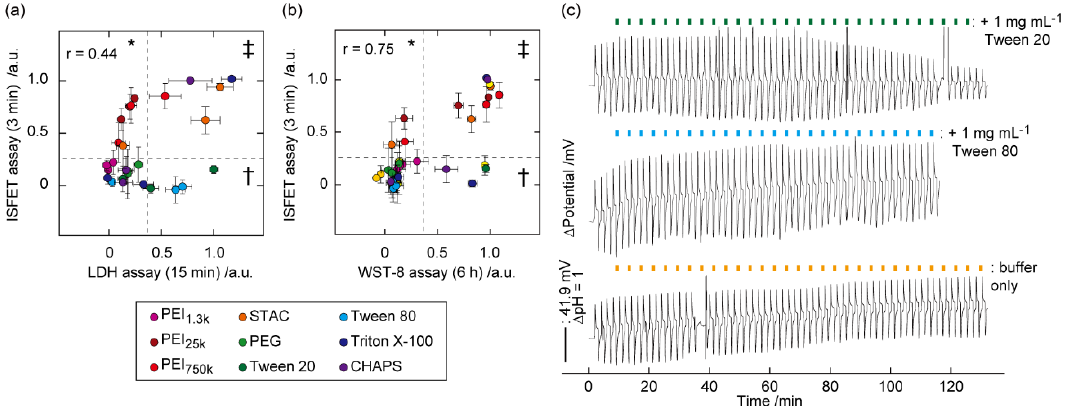
Figure 3. Cluster analysis using the ISFET vs. conventional assays and cell apoptosis detection. ( a ) Scatter plots between the ISFET (3 min) and LDH assays (15 min). *, †, and ‡ represent the ISFET + /LDH − , ISFET − /LDH + , and ISFET + /LDH + regimes, respectively. Data points identify the two signals at set concentrations with mean ± SD ( n = 3). LDH signals were normalized by those obtained at 1 mg/mL Tween 20 for 15 min. Colored symbols show chemical species. Dashed lines represent the thresholds. Correlation coefficient: r . ( b ) A scatter plot between the ISFET (3 min) and WST-8 (6 h) assays. *, †, and ‡ represent the ISFET + /WST-8 − , ISFET − /WST-8 + , and ISFET + /WST-8 + regimes, respectively. ( c ) Time course of the ISFET signal during intervals of NH 4 Cl exchanges with/without multiple exposures of the cells to 1 mg/mL Tween 20 and Tween 80. Reproduced with modification from [57] with permission by the Royal Society of